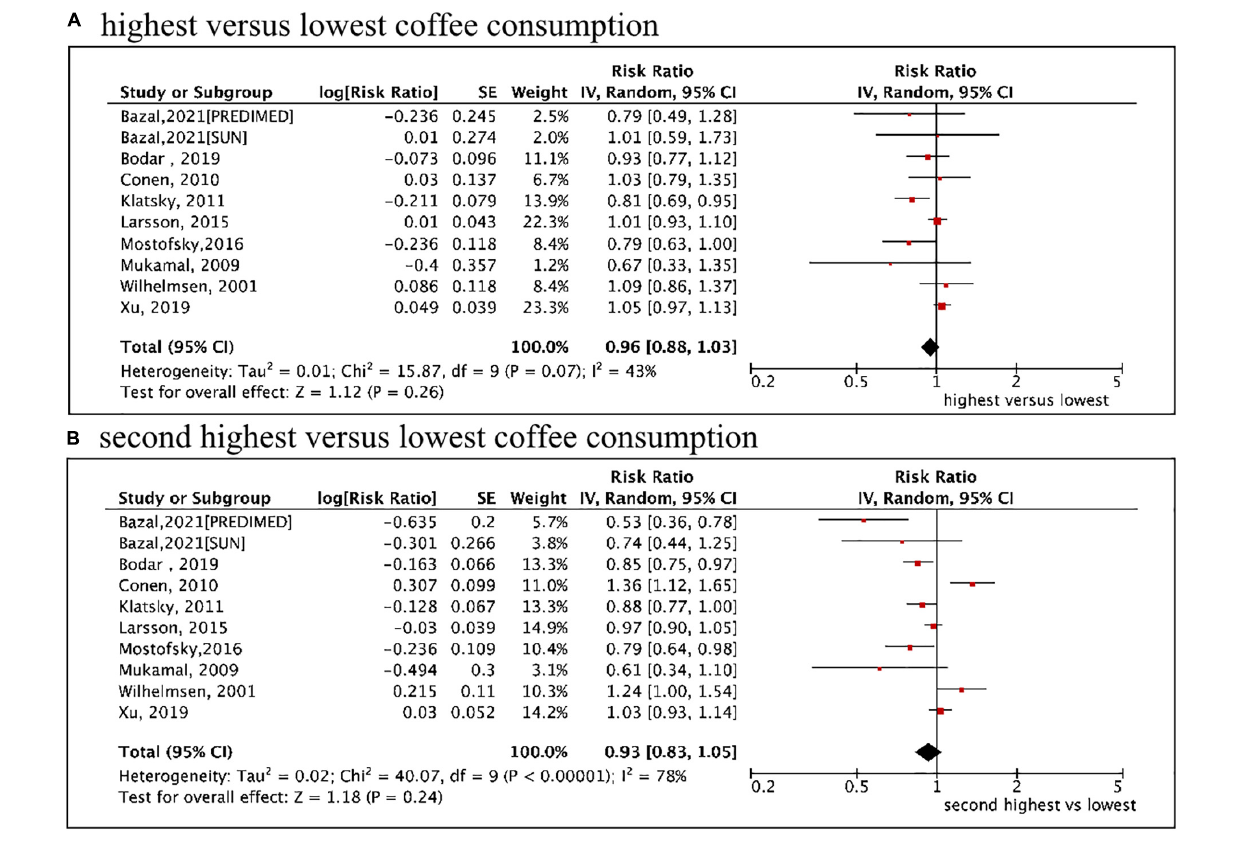
FIGURE 2 | Categorical analysis of the associations of total coffee consumption with the risk of atrial fibrillation. (A) The highest (median ≥ 4 cups/d) vs. lowest coffee intake level. (B) The second highest (median 2.5 cups/d) vs. lowest coffee intake level.